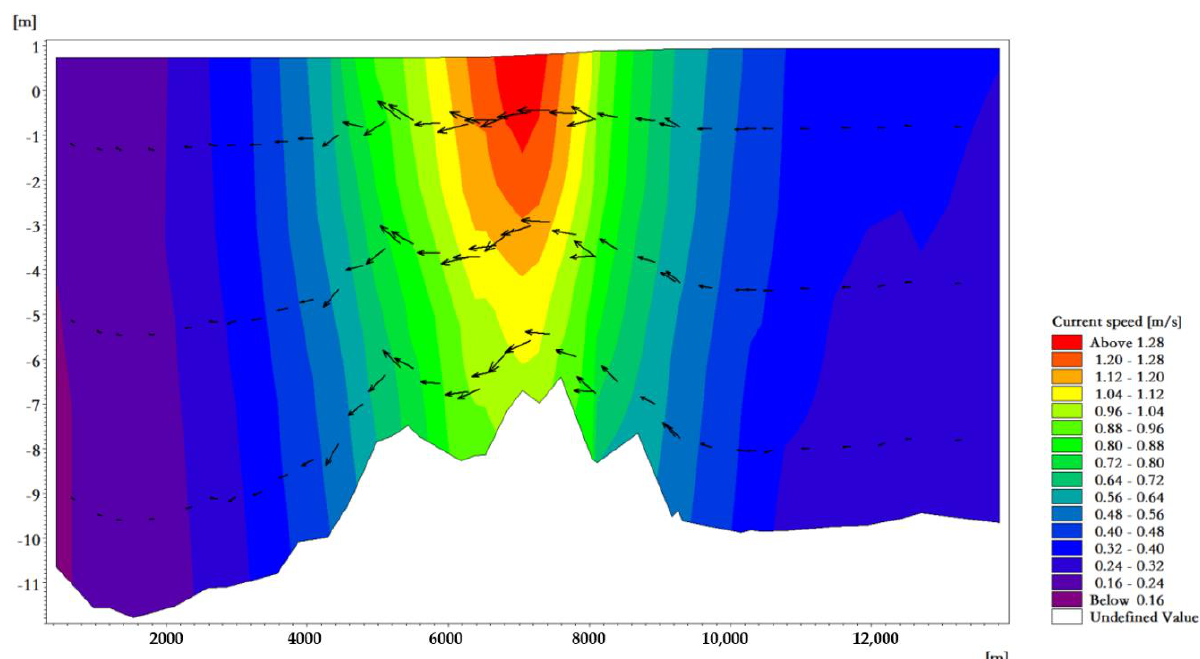
Figure 9. Flow field vertical distribution near the tidal inlet at the moment when the velocity of the flood tide reaches its maximum.